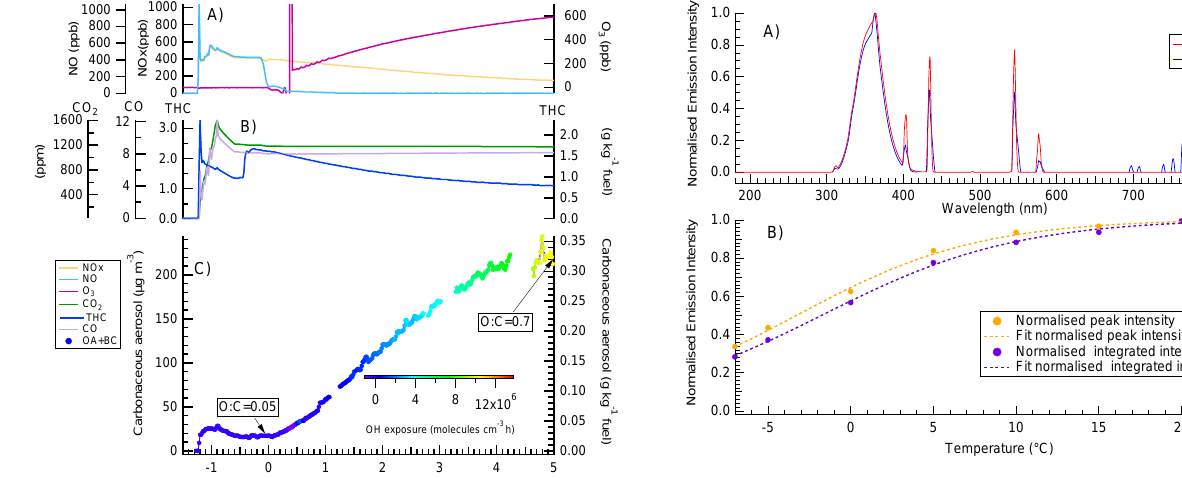
Fig. 6. (A) Emission spectrum of the UV black lights of the mo- bile smog chamber normalised to the peak in emission at 368nm at 25 ◦ C (red) and − 7 ◦ C (blue). The emission fingerprint does not change significantly over this temperature range. (B) The nor- malised intensity of the smog chamber lighting measured at 368nm and from integrating the full spectrum. The dashed lines show a power fit to the data. Intensity does not vary significantly between 10 ◦ C and 25 ◦ C (less than ∼ 10% decrease). At − 7 ◦ C, intensity is decreased significantly ( ∼ 70%